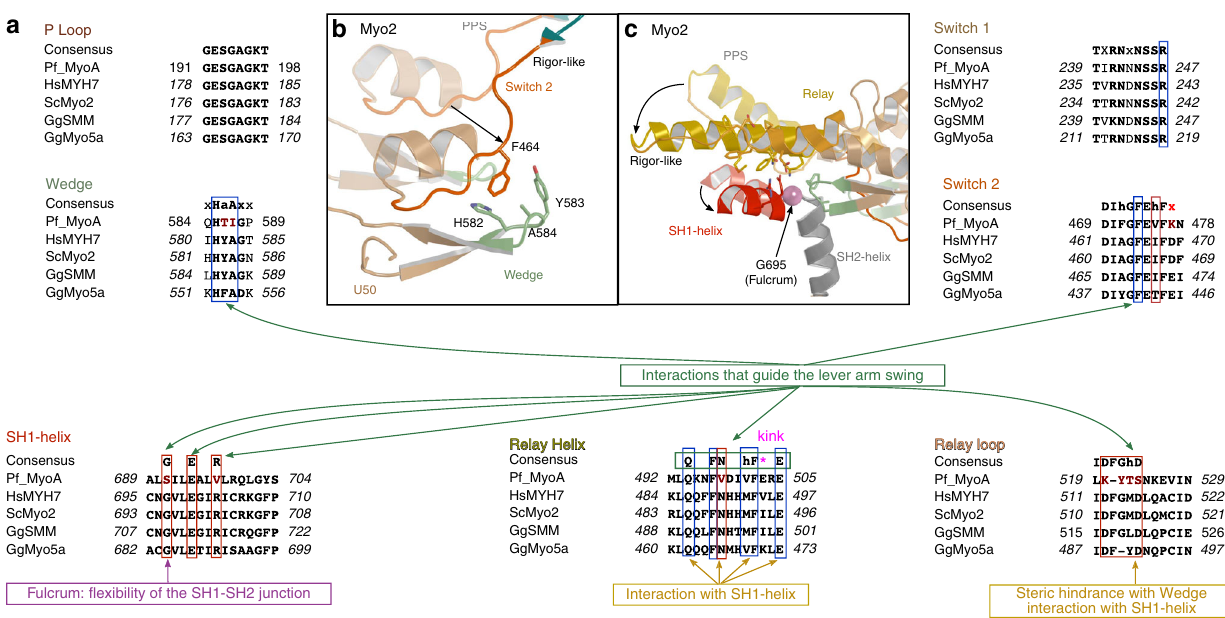
Steric hindrance with Wedge SH1-helixInteraction with SH1-helix interaction with Fig. 3 Sequence alignment of connectors essential in driving motor conformational changes – lack of canonical residues in PfMyoA. a Sequence comparison of several key elements involved in myosin mechanical transduction and allosteric communication. The consensus is represented on top of each sequence and the PfMyoA sequence is compared to other myosins. This comparison shows that the sequences of the Switch-2, Wedge, and Relay differ from the consensus. Consensus code: a is an aromatic residue, h a hydrophobic residue, x colored in red is an acidic residue. Residues important in allosteric communication in the motor are indicated in rectangles (blue rectangle if the residue is involved in a conserved interface, red rectangle if the residues are involved in interactions speci fi c to PfMyoA). If the position is not conserved in PfMyoA, the residue is colored in dark red. To see how these residues affect the PfMyoA motor rearrangements along the cycle, see Fig. 4 and Supplementary Movie 2. b Switch-2/Wedge interactions in classical Myo2. c Conformational changes of two connectors before (PPS, transparent) and after (Rigor-like, plain) the powerstroke in Myo2. The Relay helix unkinks while the SH1-helix undergoes a piston-like movement using the canonical fl exibility found at the fulcrum SH2-SH1 Gly (pink